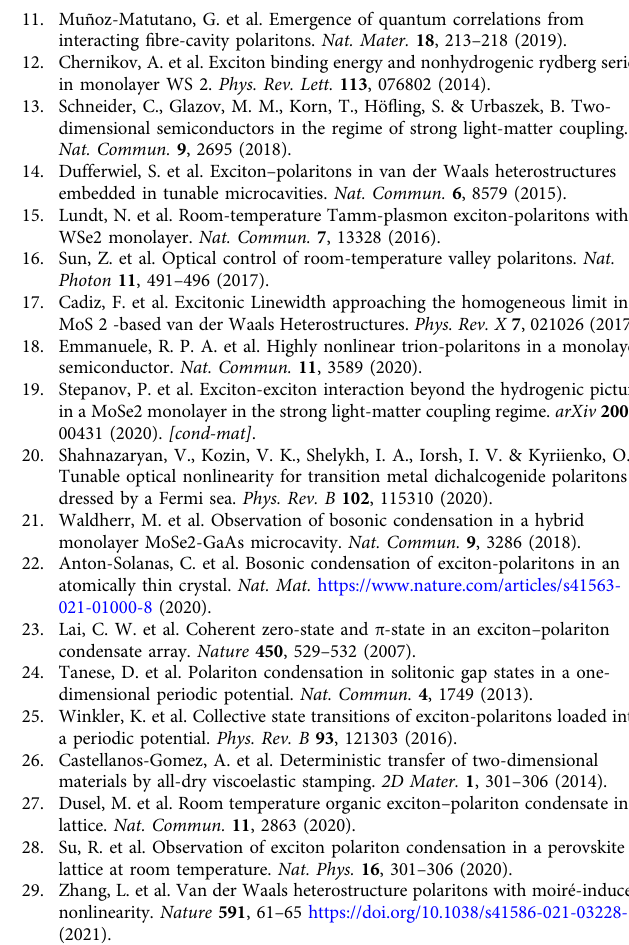
Fig. 4 Tunable coupling in a photonic lattice. a Momentum-resolved photoluminescence spectrum of a polariton chain with D/A = 1.7 for two different DBR separations of 2.184 and 2.192 µ m in the regions of k || < 0 (I, left) and k || > 0 (II, right), respectively. The map intensity is coded in a false colour scale included in the right side of the map. Each spectrum is recorded with a pump power of ~ 100 µ W and 480 s integration time. b , c Dependence of the s-band energy (magenta circles) and the p-band bandwidth (for Bloch modes 1 (BM1) and 3 (BM3), presenting an energy difference of 7 meV) versus cavity length. The labels (I, II) mark the corresponding E s and Δ E p values of panels in ( a ). The error bars in ( c , d ) represent the accuracy in the energy